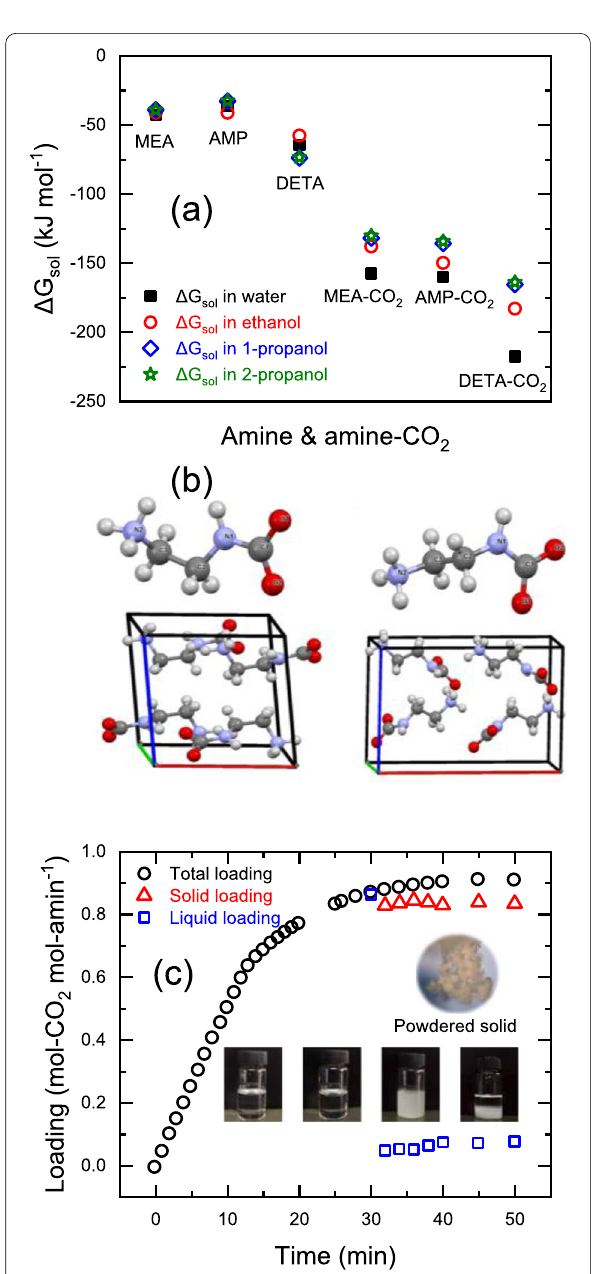
Fig. 3 a Variation in solvation free energy (ΔG sol ) of selected amines in different solvents (Reproduced from [31] with permission from Elsevier). b Crystal structure of monoclinic and orthohombic EDA‑carbamate formed in DMF solution and DMA solution, respectively (Reprinted from [32] with permission from Elsevier). c Precipitation behavior of TETA/AMP in NMP upon CO 2